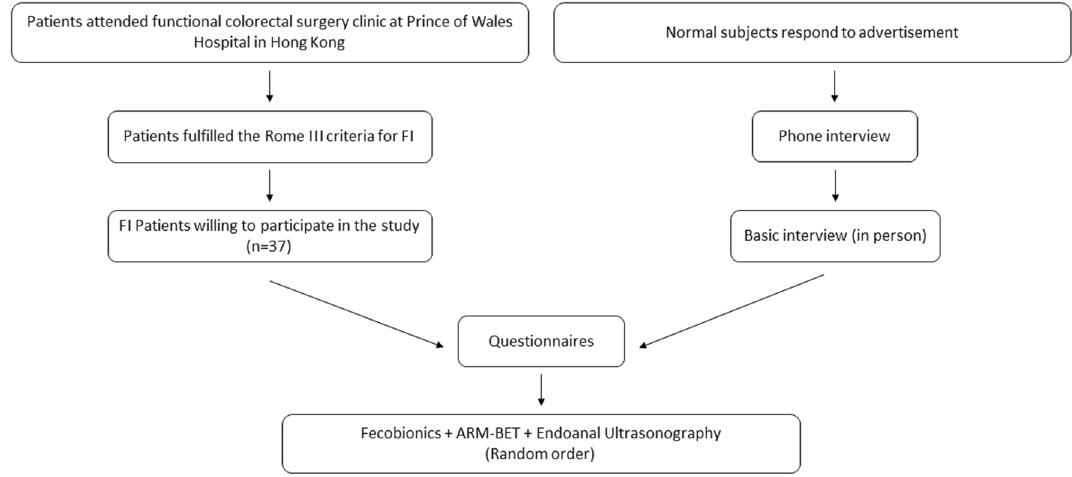
Figure 1. Inclusion and testing